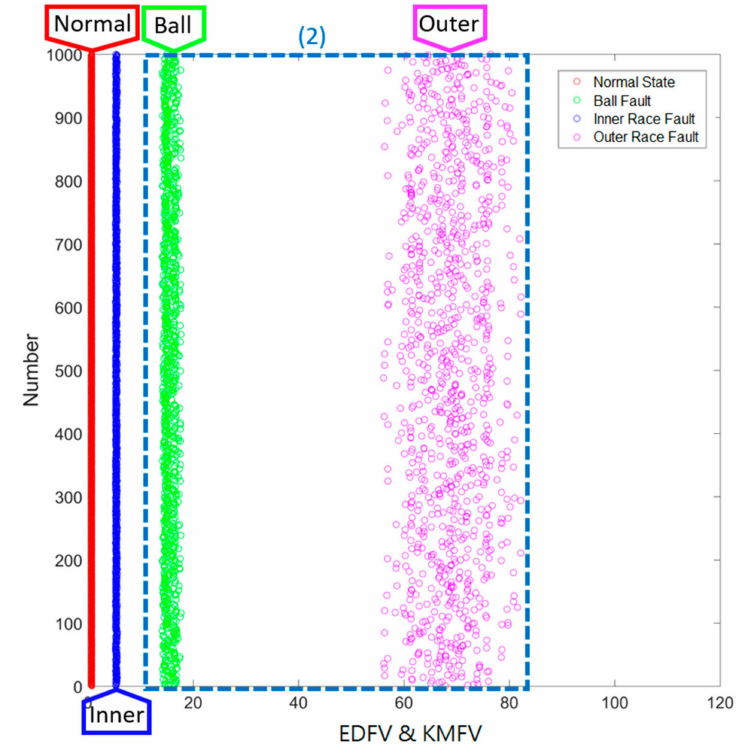
Figure 13. Results of Method 2: EDFV + KMFV (Hierarchical